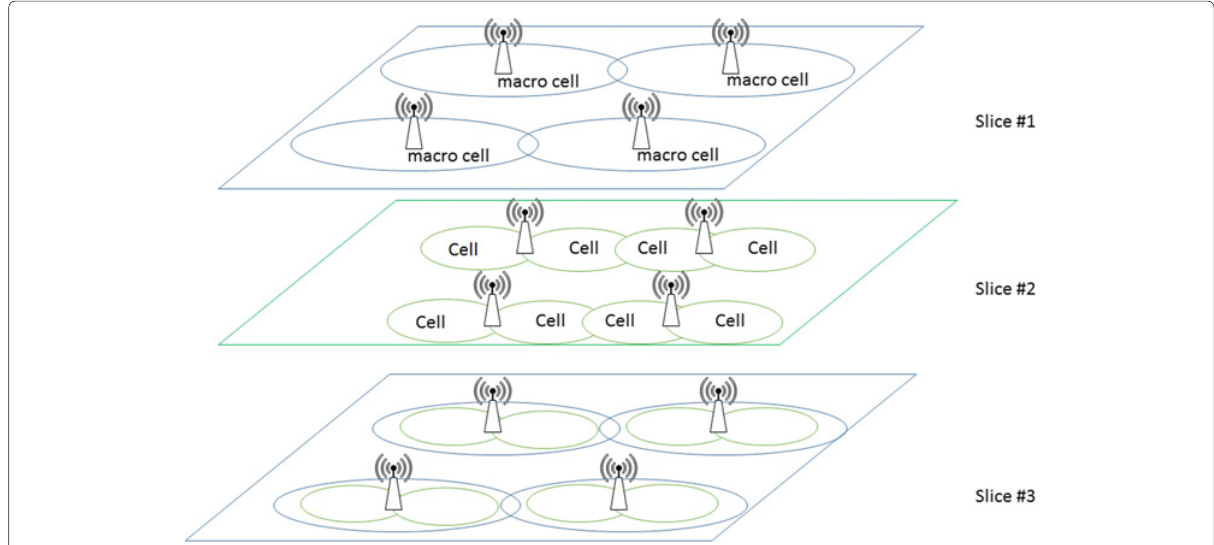
Fig. 3 Network slicing in RAN, based on